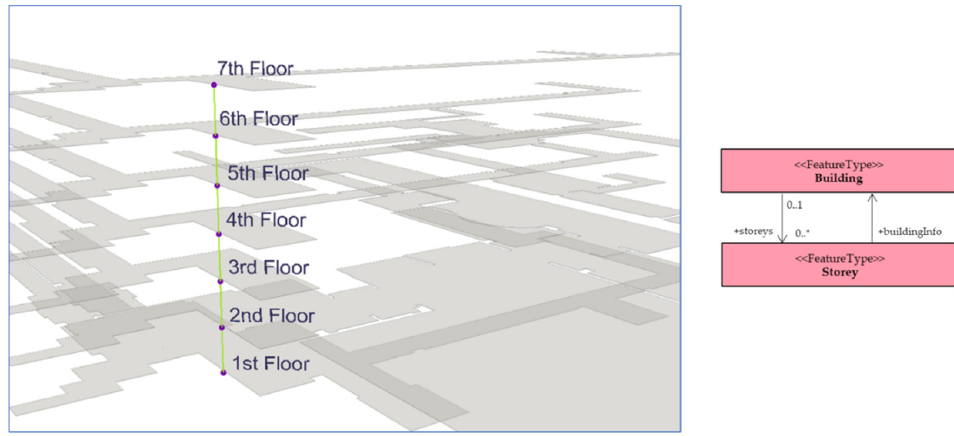
Figure 12. Level 1 network data representing building floor levels.